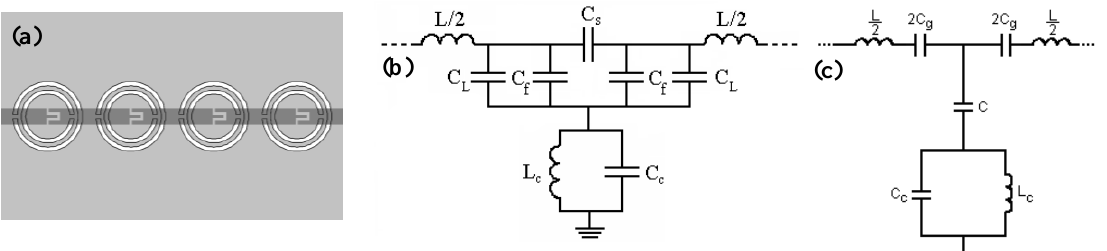
Figure 12. ( a ) Typical topology of a CSRR- and gap-loaded microstrip line. ( b ) Equivalent circuit model of the unit cell. ( c ) Transformed circuit